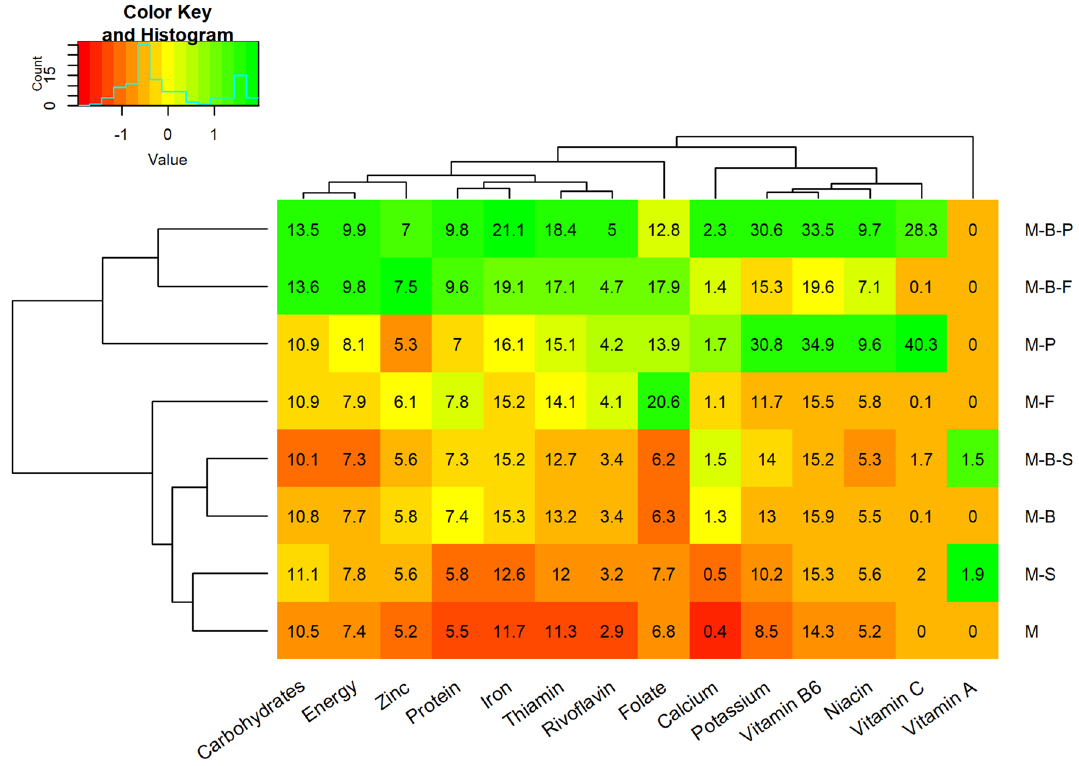
Western Highlands of Guatemala. Crop associations codes are: M-P: Maize-Potato, M-B-S: Maize-Bean-Squash, M-B-P: Maize-Bean-Potato, M-B: Maize-Bean, M-F: Maize-Faba, M: Maize monocrop, M-S: Maize-Squash, M-B-F: Maize-Bean-Faba. The colour-code denotes a gradient (of scaled PNPF values) from high PNPF in green to low PNPF in red, crop associations and nutrients are clustered in a dendrogram (in black to the left and top respectively) according to the PNPF values (Created using heatmap.2 function from the R package gplots -http://cran.r-proje ct.org/web/packa ges/gplot s/index